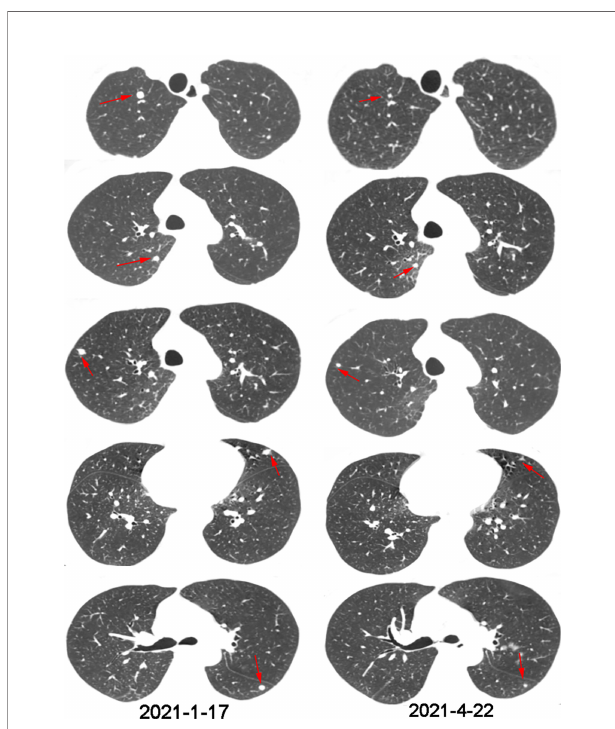
FIGURE 4 | Chest CT scans before and after one cycle of triple-combination therapy and two cycles of sintilimab